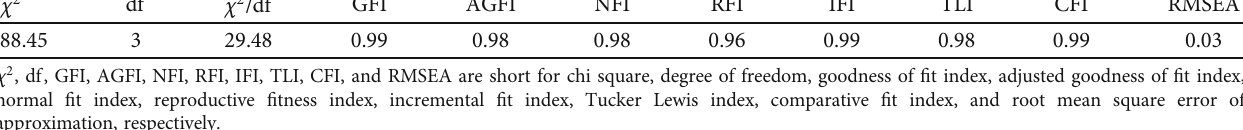
Figure 2: Mediating e ff ect of interpersonal trust on the relationship between self-esteem and social anxiety. Table 4: Fitness indices for the mediating e ff ect of interpersonal trust on the relationship between self-esteem and social anxiety. χ